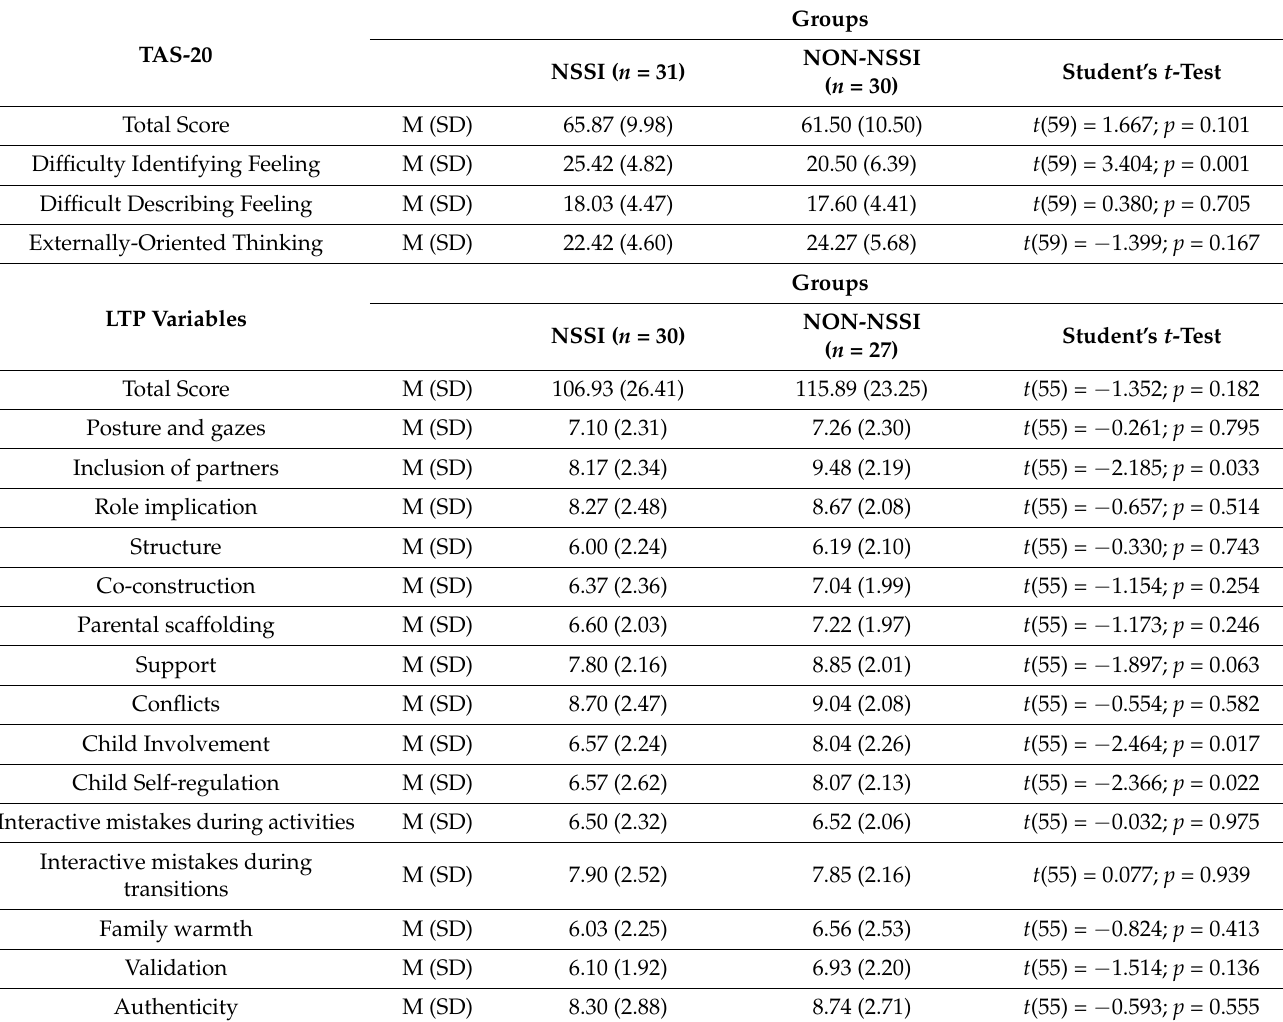
Table 3. Toronto Alexithymia Scale (TAS-20), Lausanne Trilogue Play (LTP) Mean (M), standard deviation (SD) and Student’s t ( t -test) in the two